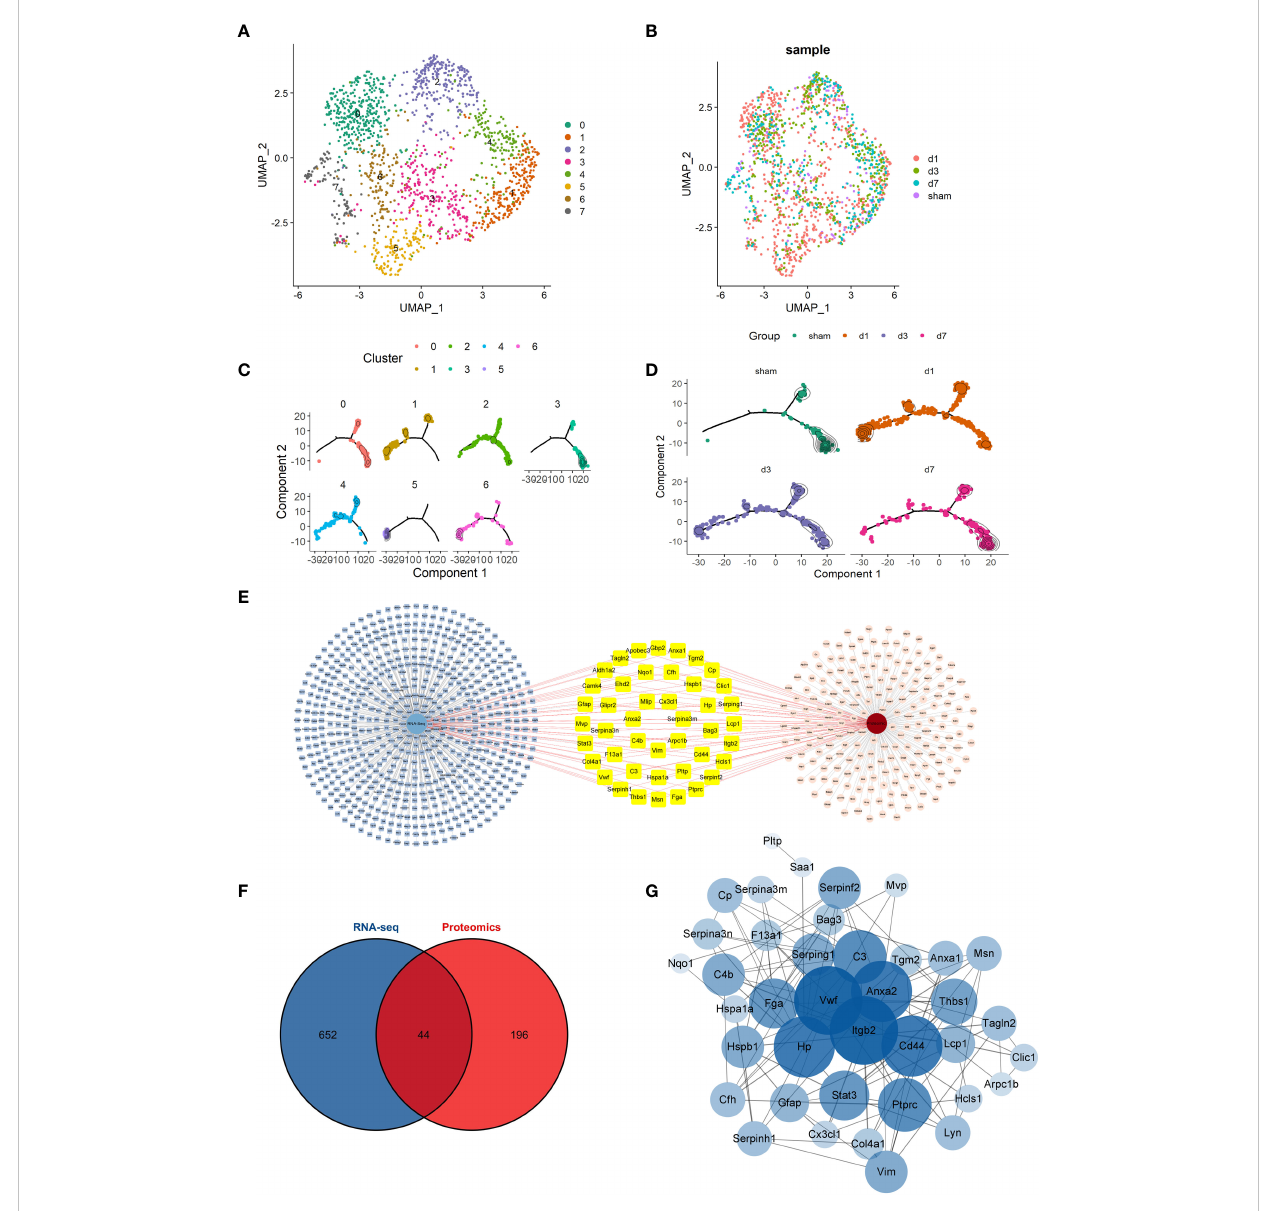
FIGURE 2 Overview of conventional scRNA-seq analysis and scSTAR analysis of microglia (A, B) UMAP of the microglia subcluster and the distribution of cells at time points by the conventional analysis method. (C, D) Trajectory analysis of the microglia subcluster and the distribution of cells at time points by scSTAR. (E) Details of 44 differentially expressed genes co-expressed in RNA-Seq and proteomic. (F) A Venn plot of 44 DEGs was both in RNA- Seq and proteomic differentially expressed genes or proteins. (G) Network Analyzer of 44 shared